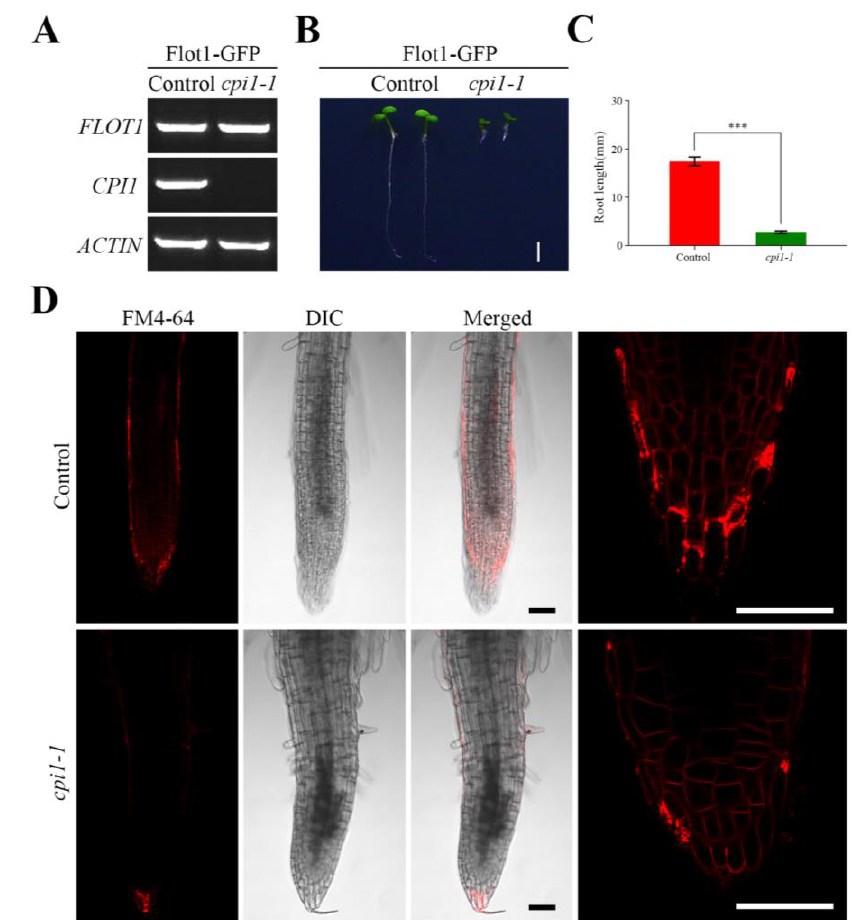
Figure 1. Characterization of the root in Flot1-GFP transgenic mutants. ( A ) Semiquantitative RT-PCR analysis of Flot1 expression in control seedlings and cpi1-1 mutants. ( B ) A typical cpi1-1 mutant plant and wild-type transgenic Arabidopsis thaliana . Scale bar, 0.25 cm. ( C ) The root length of Flot1-GFP / control and Flot1-GFP / cpi1-1 mutants. Data shown are from 43 to 65 plants. Error bars represent the SD ( n = 3). *** p < 0.001, Student’s t -test. ( D ) The shape of a typical root cell in cpi1-1 mutants and wild-type transgenic Arabidopsis thaliana . Scale bars, 50 µm.